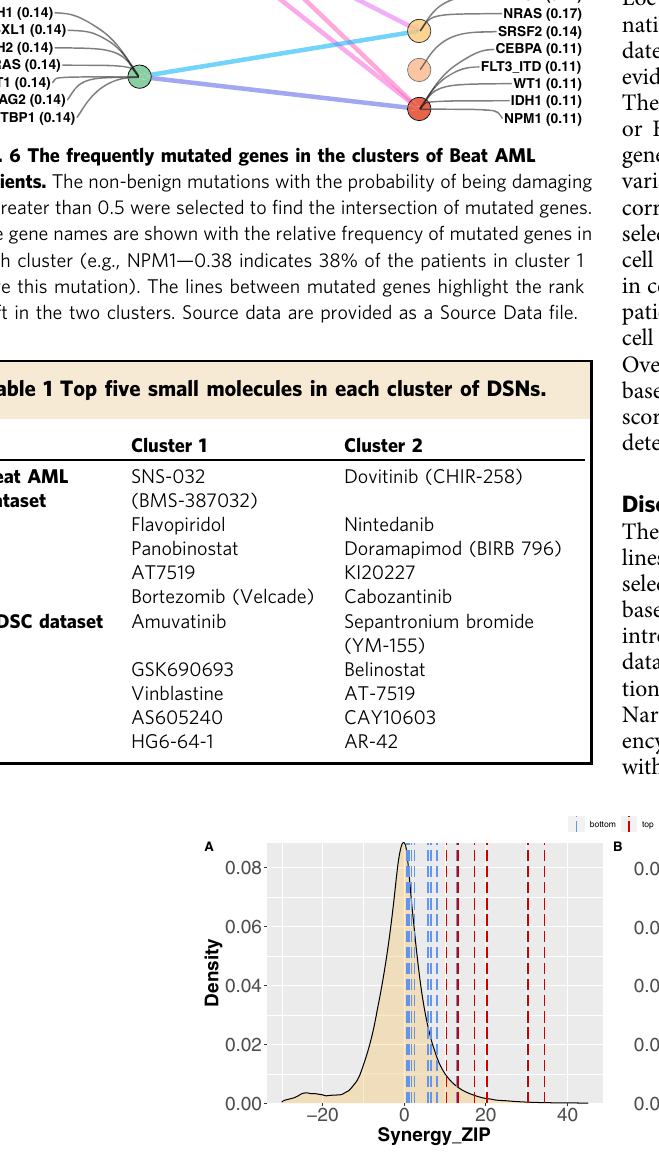
Fig. 7 Distribution of drug combination synergy scores in the DrugComb database. The median of synergy zip score for the top and bottom fi ve drugs are represented by dashed lines in Beat AML dataset ( A ) and the GDSC dataset ( B ). The y-axis represents the probability density function of synergy zip in the DrugComb database, whereas the x-axis represents synergy computed using the ZIP method. Source data are provided as a Source Data fi